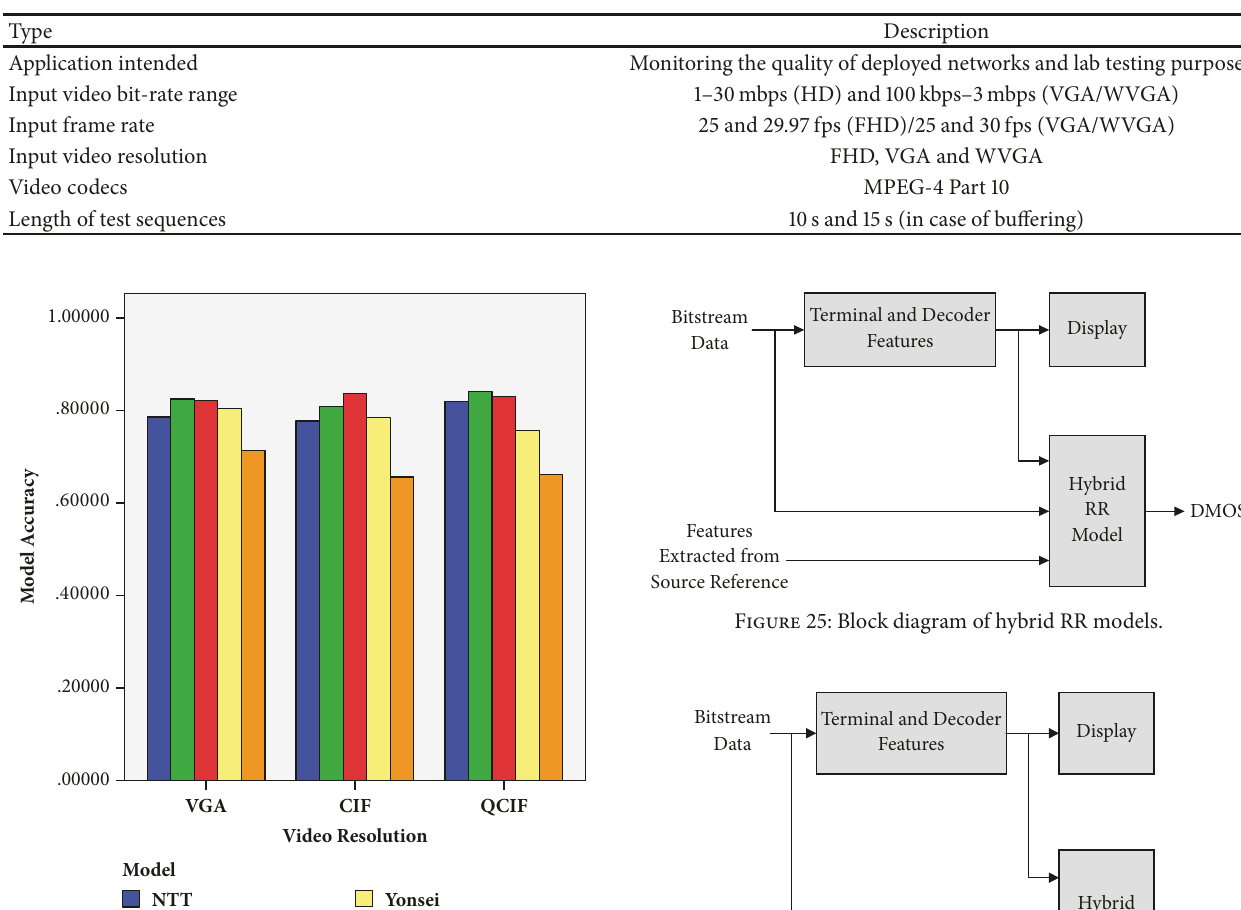
Table 14: Application areas, test factors, and technology used by the ITU-T J.343 model series.